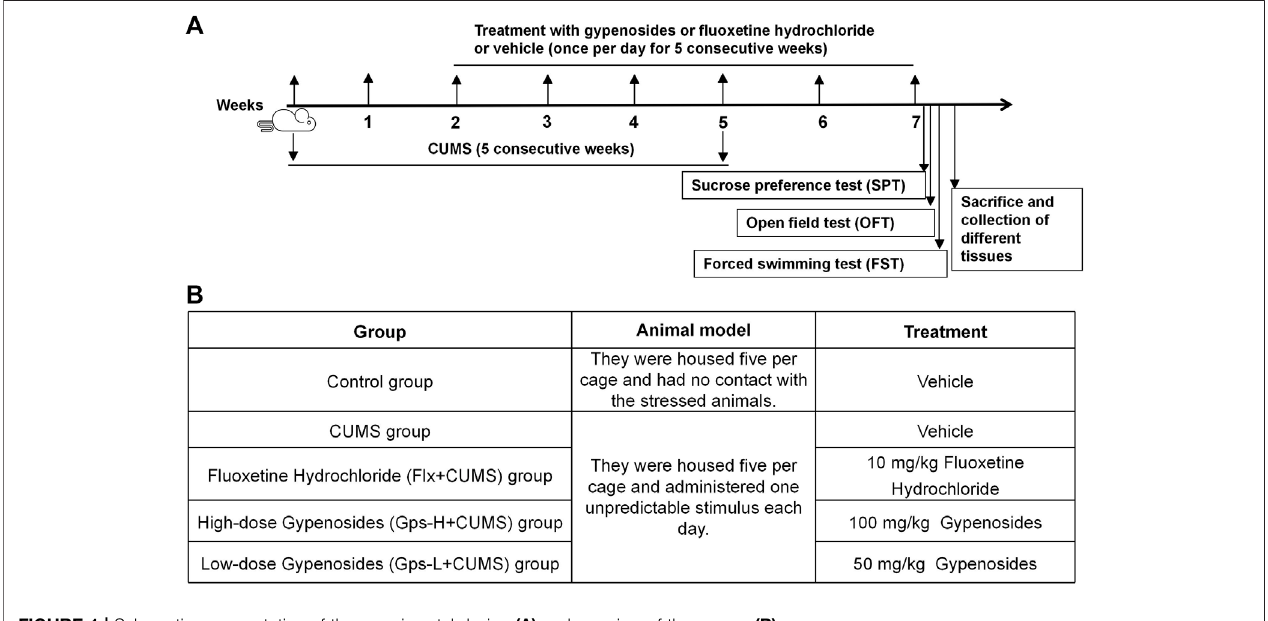
FIGURE 1 | Schematic representation of the experimental design (A) and overview of the groups (B) .